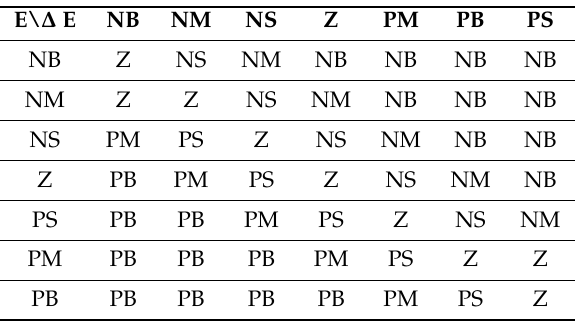
Figure 6. Graph used to define the rules of the system. Table 3. Rules of the System.